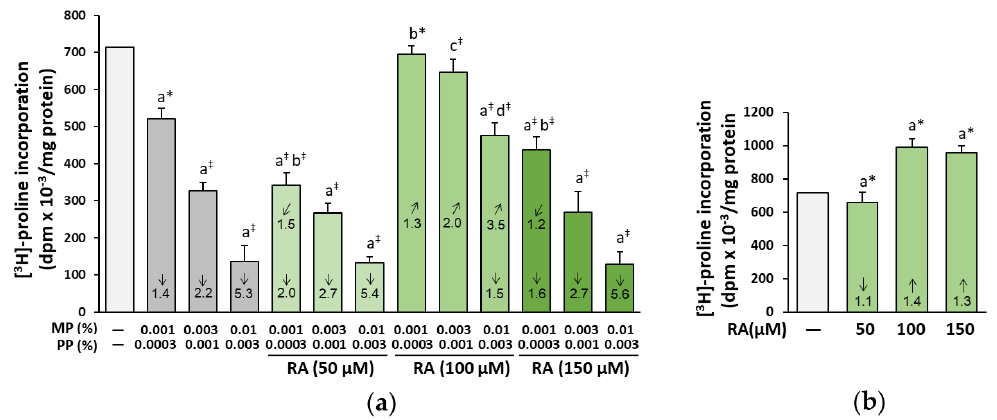
Figure 2. The influence of rosmarinic acid (RA) on the biosynthesis of collagen in the fibroblasts treated with methylparaben (MP) and n-propylparaben (PP) ( a ) and untreated cells ( b ). The mean values ± SD of three experiments done in duplicate are presented. Statistically significant differences are marked as: a vs. control, b vs. 0.001% MP and 0.0003% PP, c vs. 0.003% MP and 0.001% PP, d vs. 0.01% MP and 0.003% PP; * p < 0.05; ‡ p < 0.001. The values in the bars show a factor of change in alone (MP and PP) ( ↗ , increase; ↙ , decrease). Table 1. Estimation of the main and interactive effects of parabens (methylparaben—MP and